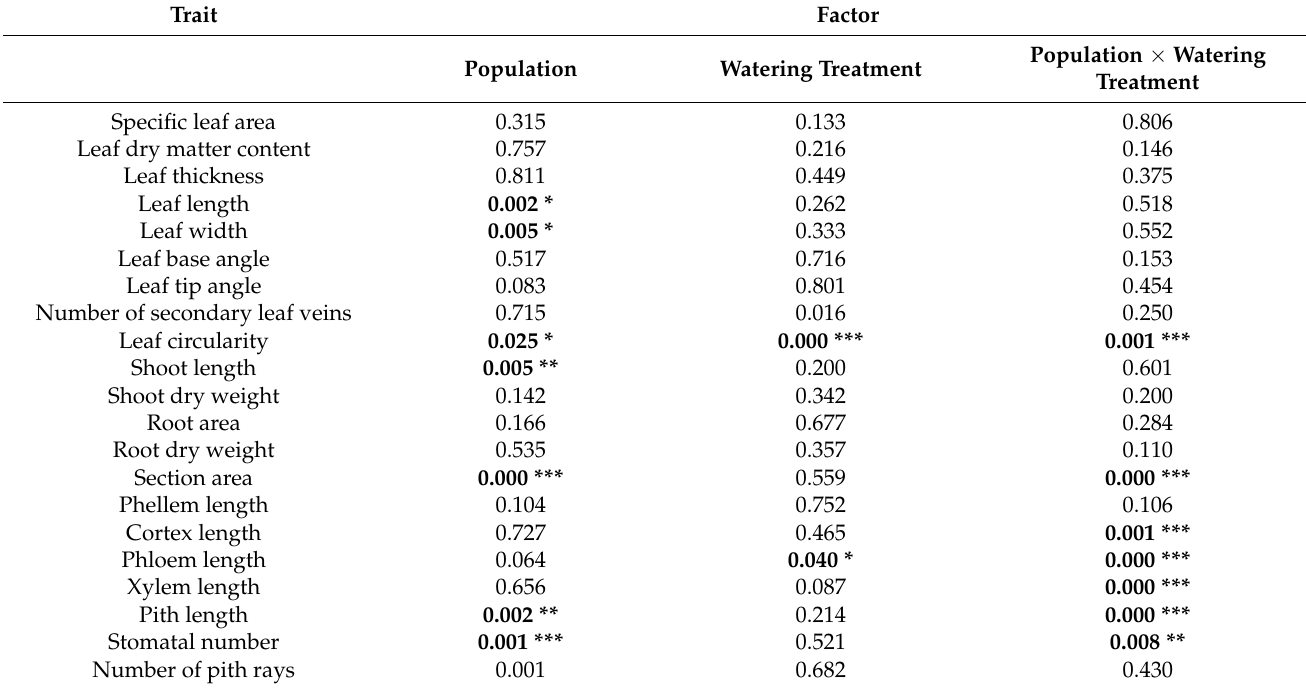
Figure 2. Survival percentages of beech seedlings at the end of the experiment under each watering treatment. The vertical lines show the standard error of mean values. Mean values between populations followed by the same capital letter (separately for each watering treatment) do not statistically differ at 5% level of significance. Table 2. Results of mixed model analysis for trait differentiations across watering treatments and